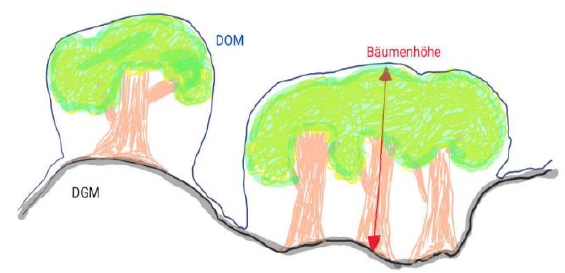
Figure 4 . Representation of DOM, DTM and height of